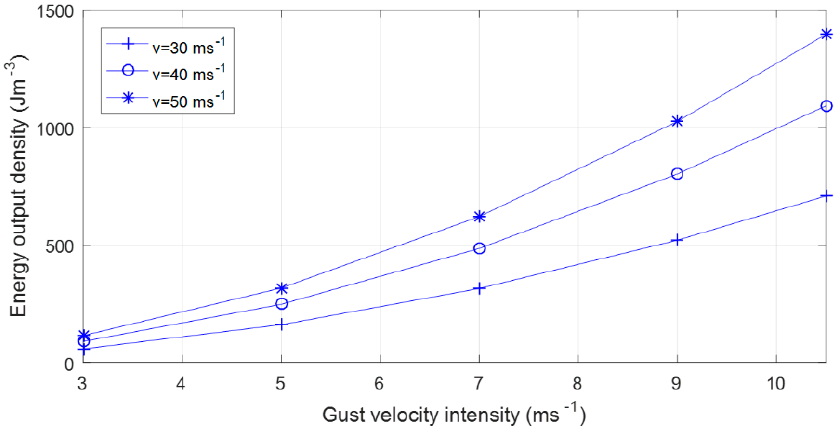
Figure 6. Energy output density with gust velocity amplitude under different airflow velocity ( v ) at the leading edge symmetric PZTs layers of wing root, 100 m gust wavelength.